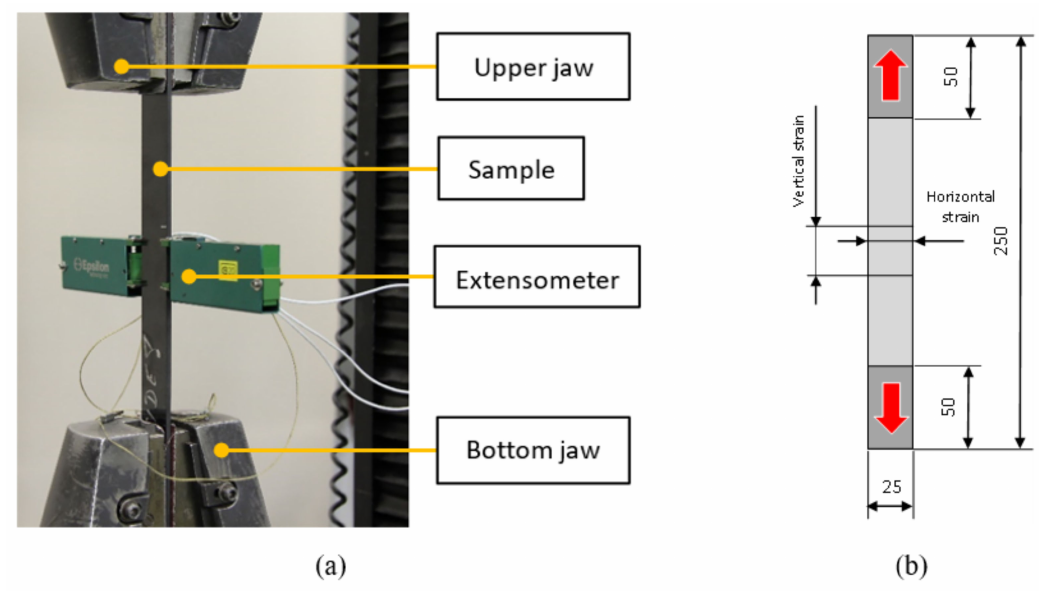
Figure 3. Tensile test; Experiment ( a ); Tensile sample ( b ).